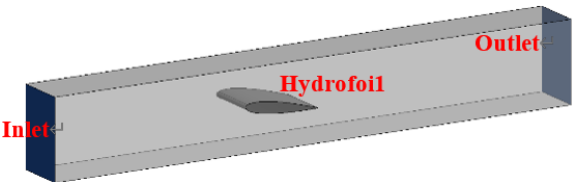
Figure 4. 3D model of the NACA0015 hydrofoil.